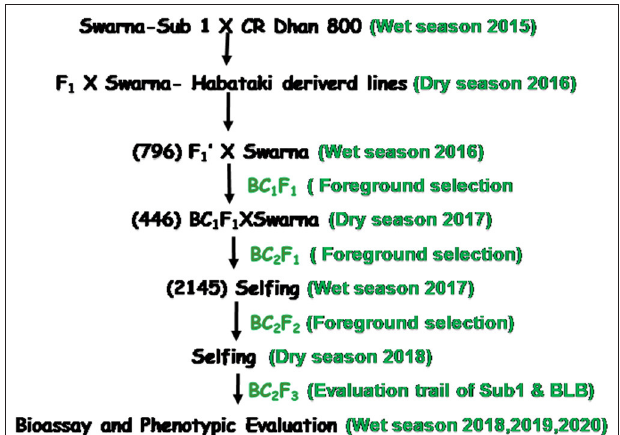
FIGURE 1 | Flowchart for development of submergence tolerant, bacterial blight resistant, and high yielding genotype in the background of popular variety, ‘Swarna’ through the marker-assisted breeding